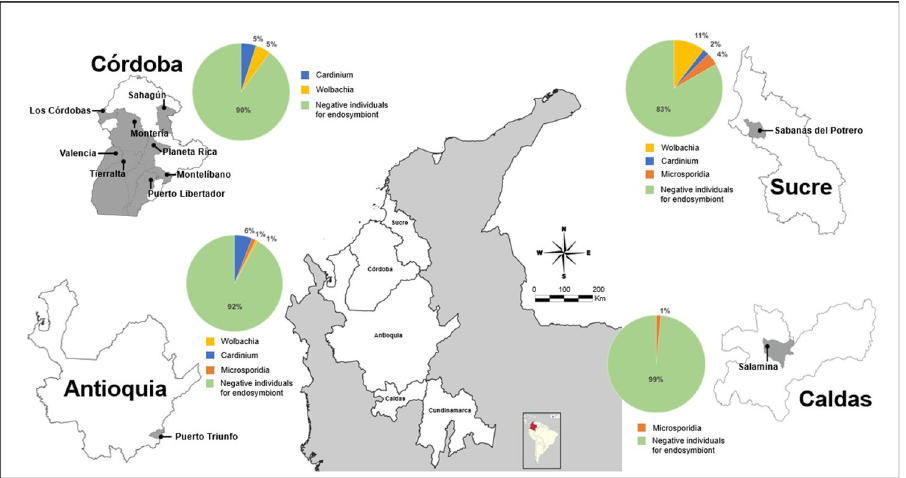
Fig 1. Geographic locations of sampling sites and proportion by department of insect vectors (Phlebotomine sand flies and mosquitoes) infected with Wolbachia , Cardinium and Microsporidia in Colombia. Link to the base layer of the map used: https://www.colombiaenmapas.gov.co/?e=-74.7117818345732,0.23307652371168444,-62. 73668417832639,8.735414279337139,4686&b=dark-gray&u=0&t=2901&servicio=610.